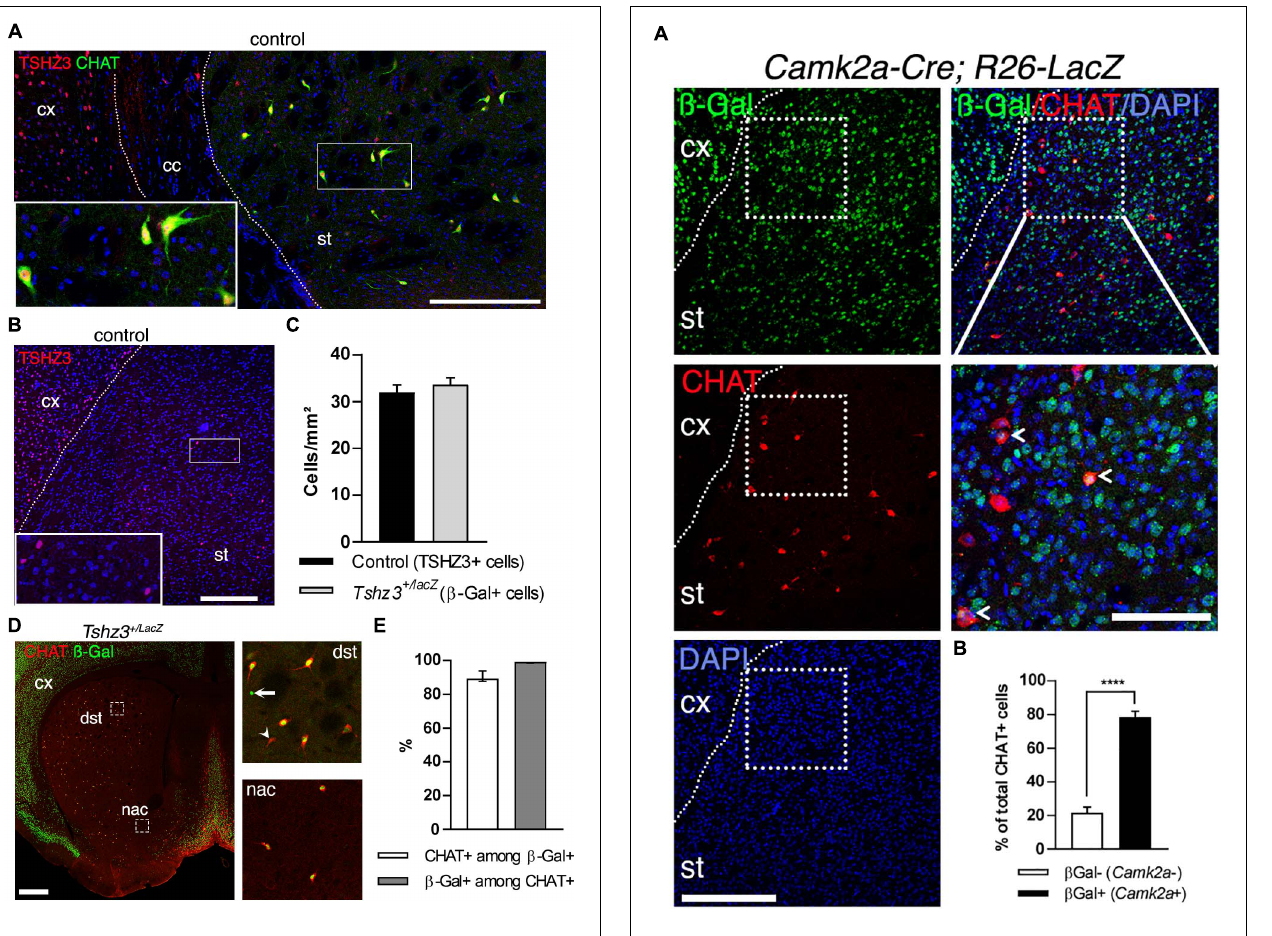
FIGURE 2 | Expression of Camk2a-Cre in SCINs. (A) Coronal brain section from a Camk2a-Cre;Rosa26-stop-LacZ mouse stained for ß-Gal (TSHZ3) and CHAT. Scale bar, 200 µ m. The boxed region is magnified to show ß-Gal/CHAT double positive SCINs (arrowheads). Scale bar, 100 µ m. (B) Distribution of ß-Gal-negative and ß-Gal-positive cells among CHAT-positive cells (20 sections from three mice per genotype; **** P < 0.0001, Student’s t -test; data are expressed as means + SEM). cx, cerebral cortex; st, striatum. Nuclei were counterstained with DAPI